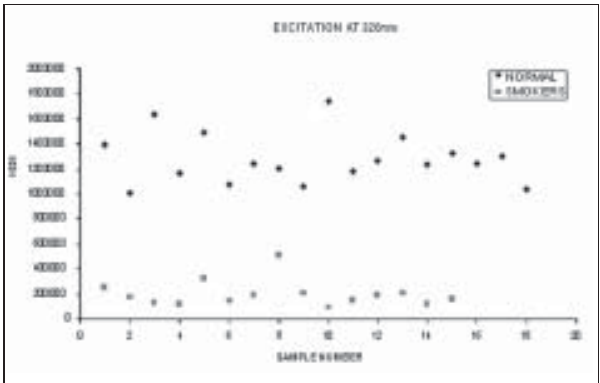
Fig. 6 - Scatter plot of intensity value at 380nm Vs sample number for pan chewers and tobacco smokers from fluorescence emission at 320nm excitation